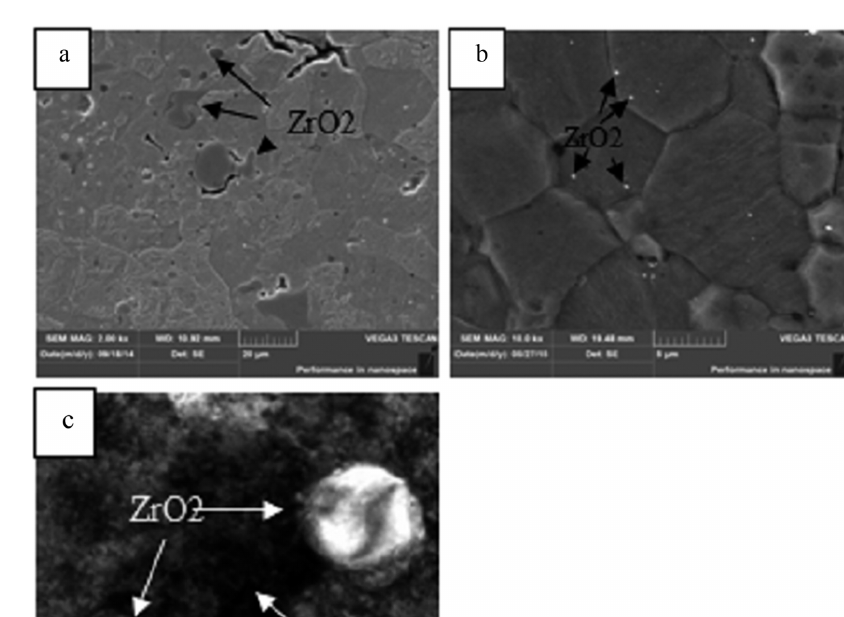
Figure 1: SEM images ( × 5.0 kx) of molybdenum power: (a) Mob. Mo-1.0% ZrO 2 .